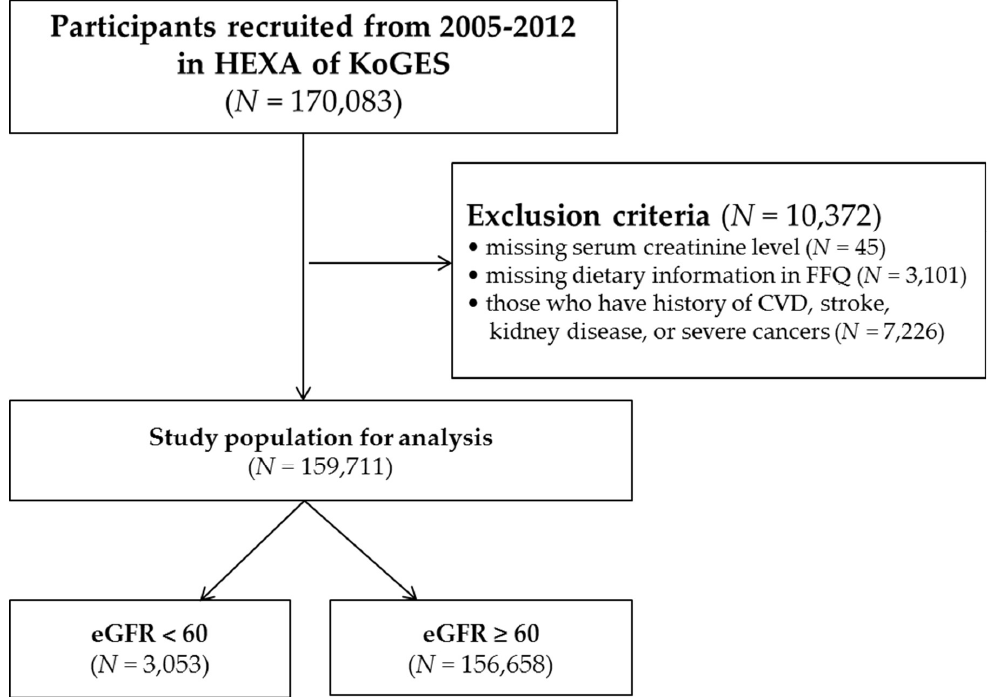
Figure 1. Flow chart of exclusion criteria to specify the study population.